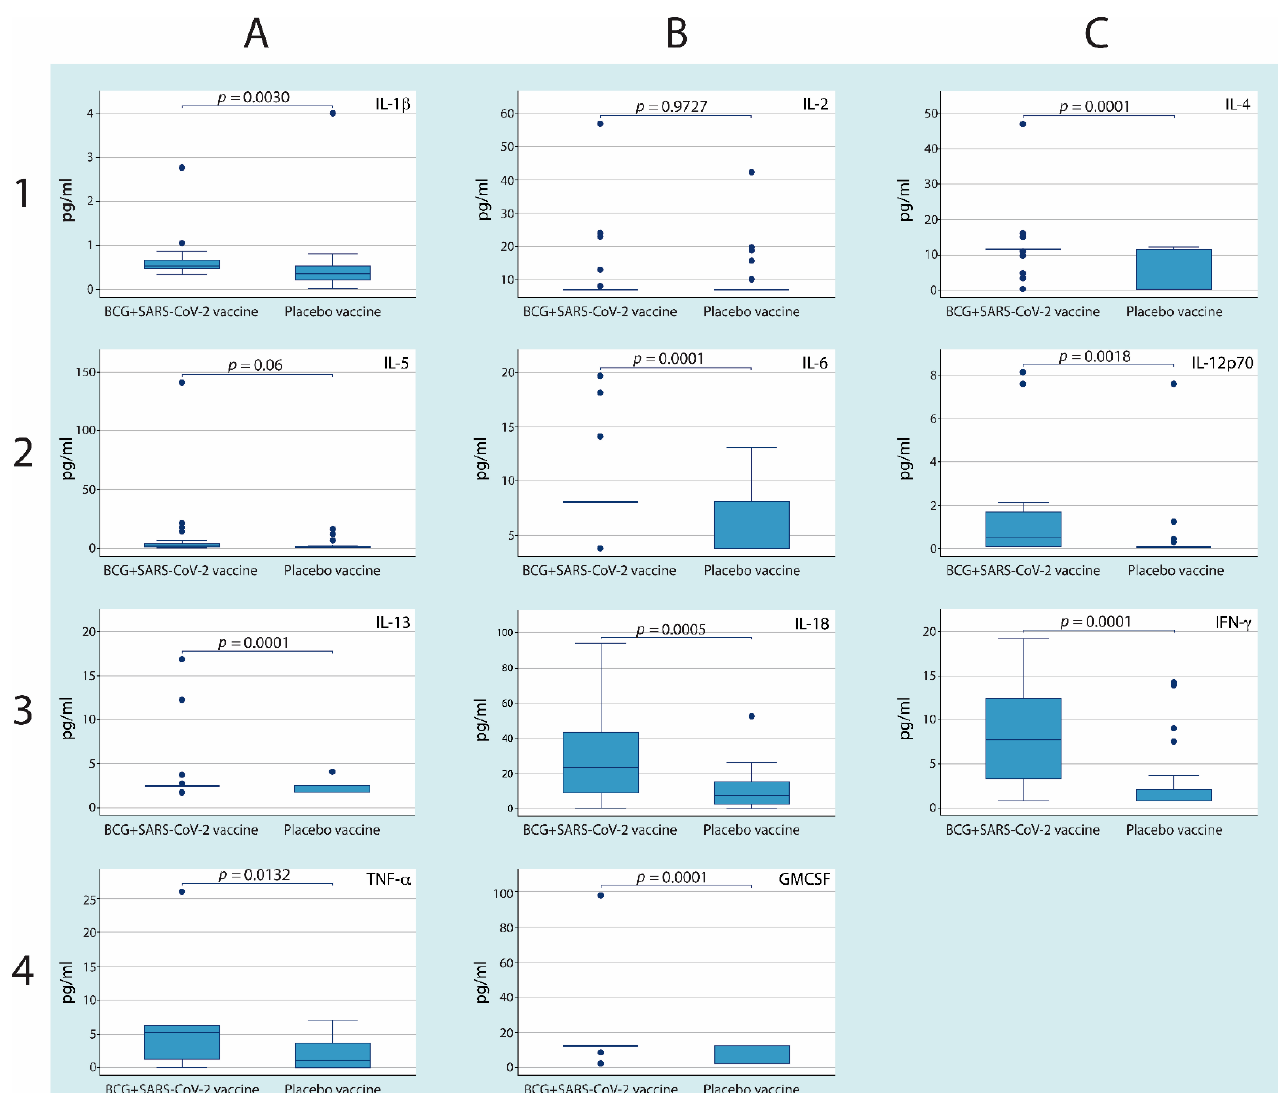
Figure 2. BCG revaccination followed by SARS-CoV-2 immunization induces higher levels of serum cytokines. Blood was drawn from each donor ( n = 30 per group) thirty days after step 3, and cytokine levels were measured by ELISAs. Each graph shows a particular cytokine. Boxes represent the median ± IQR, whiskers extend to 95% confidence intervals, and individual dots represent outlier values. The lines show the p -values for comparisons between different groups.